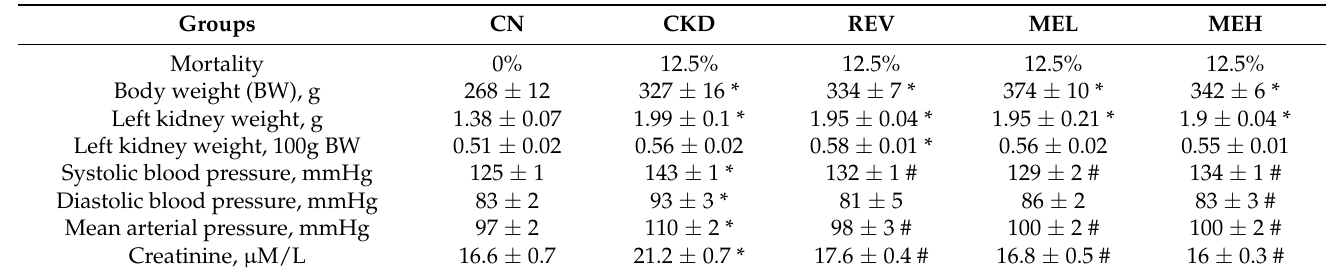
Table 2. Weights, BP, and renal functions of 12-week-old rats.